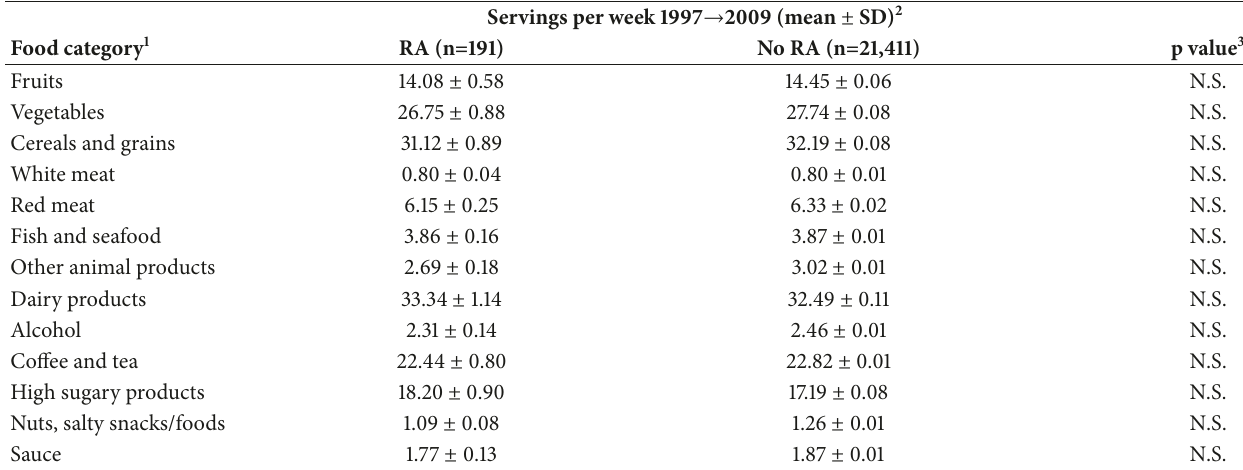
Table 3: Multivariable adjusted changes in dietary intake (servings/week) from 1997 and 2009 between women with and without